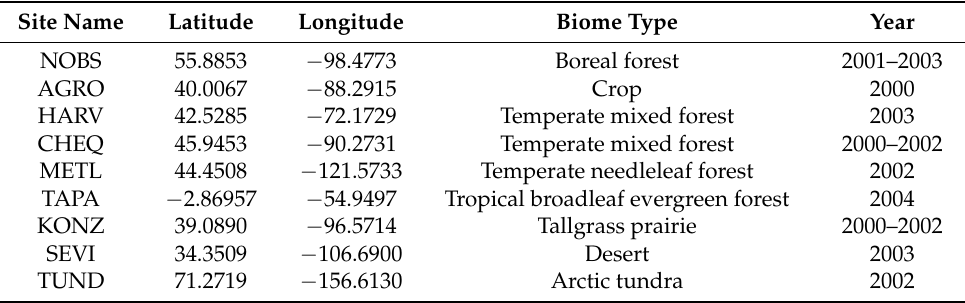
Table 1. Basic information of BigFoot